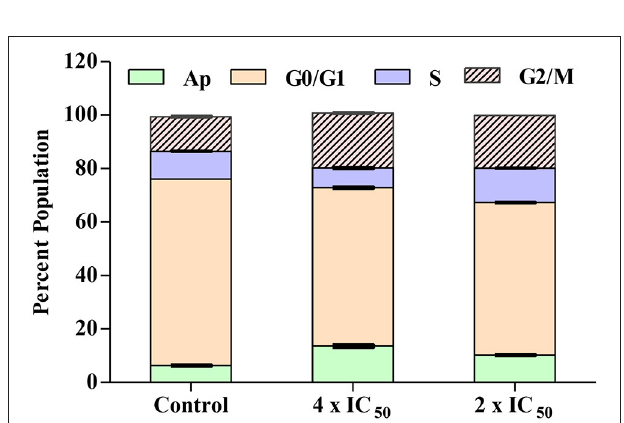
FIGURE 6 | Carvacrol arrest the G2/M phase of FaDu cells. Treated FaDu cells were stained with propidium iodide (PI) to determine the arrest of the diverse phase of cells by following a protocol written in the materials and methods section. FACS Diva software was employed to set parameters (SSC, FSC, and PI) and gated concerning untreated FaDu cells. Carvacrol arrests the G2/M phase and increases the number of sub-diploid populations.